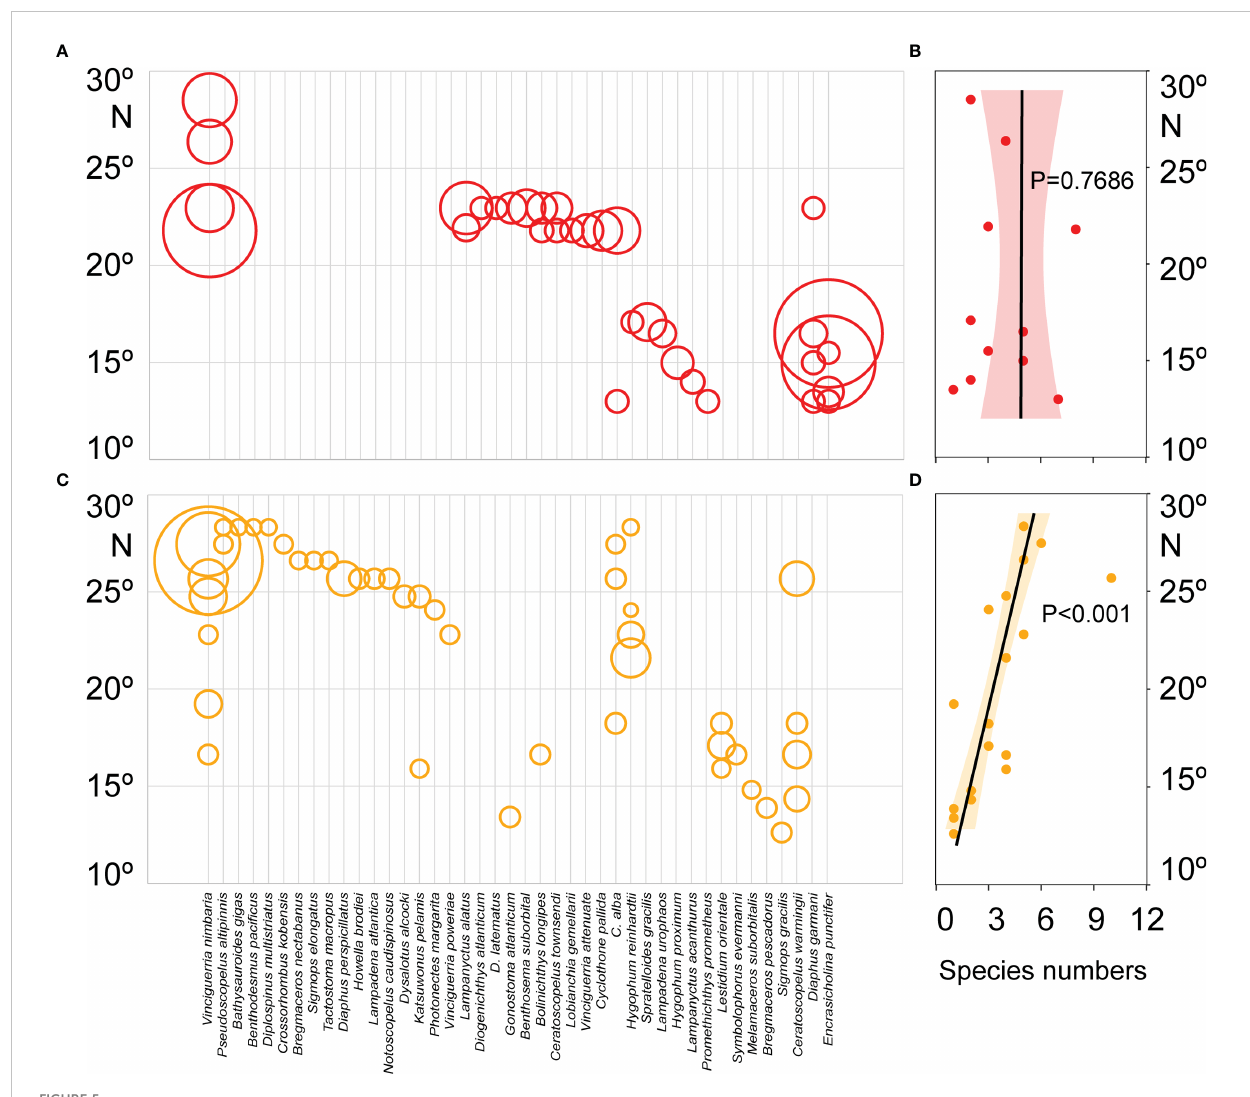
FIGURE 5 Latitudinal distribution patterns of fi sh larvae abundance and species numbers in the 135°E transect of the Philippine Sea during the summer (A, B) and autumn (C, D) . The Larvae abundance showed by the size of the circle. The latitudinal trends of species diversity were analyzed based on the linear regression model, signi fi cance by